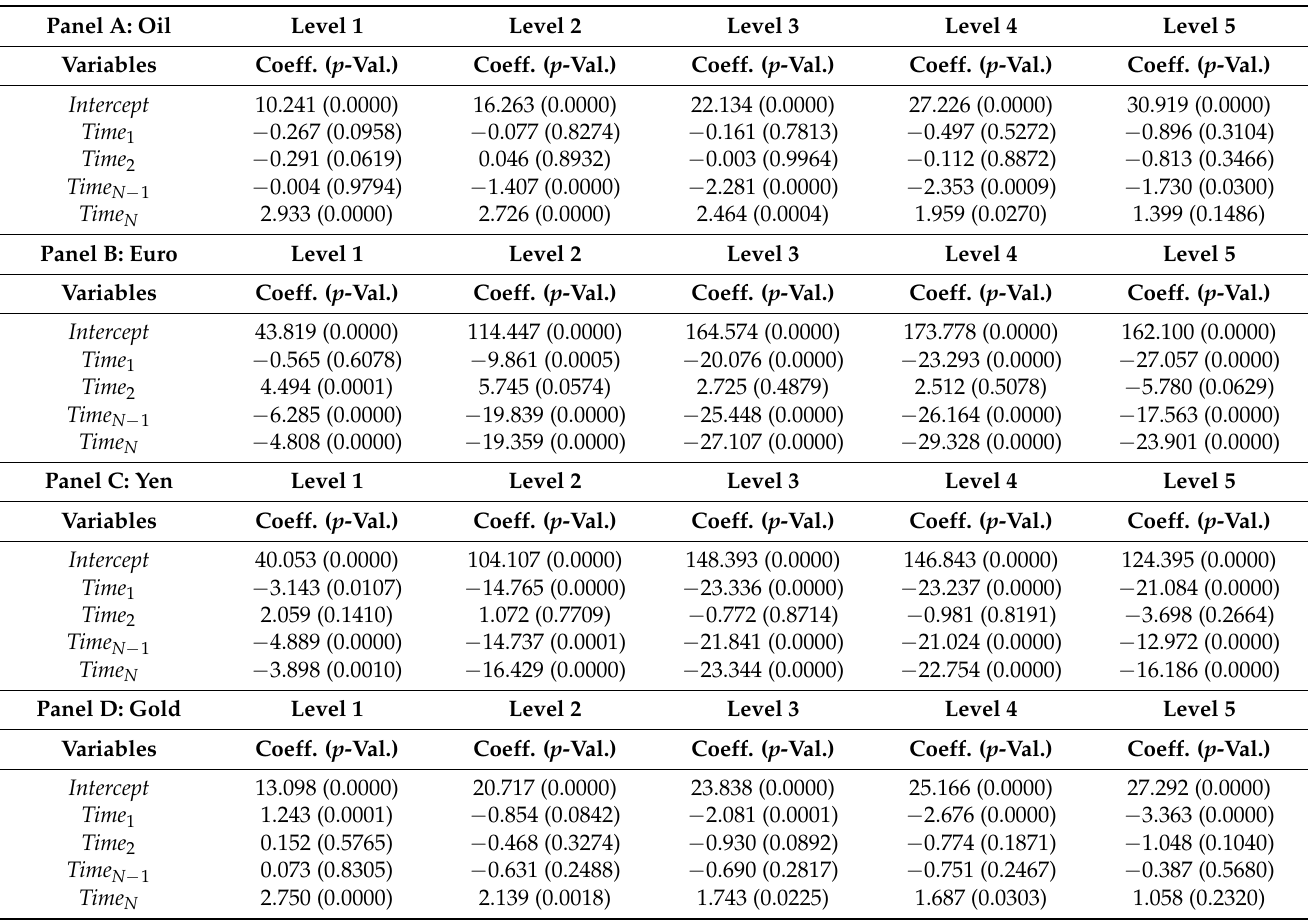
Table 4. Intraday patterns of depth at each